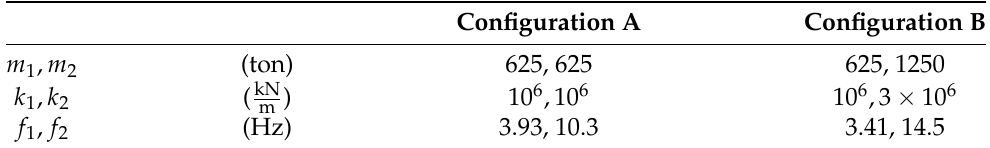
Table 1. Two-storey shear building model: data relevant to configurations A and B, see Figure 7.